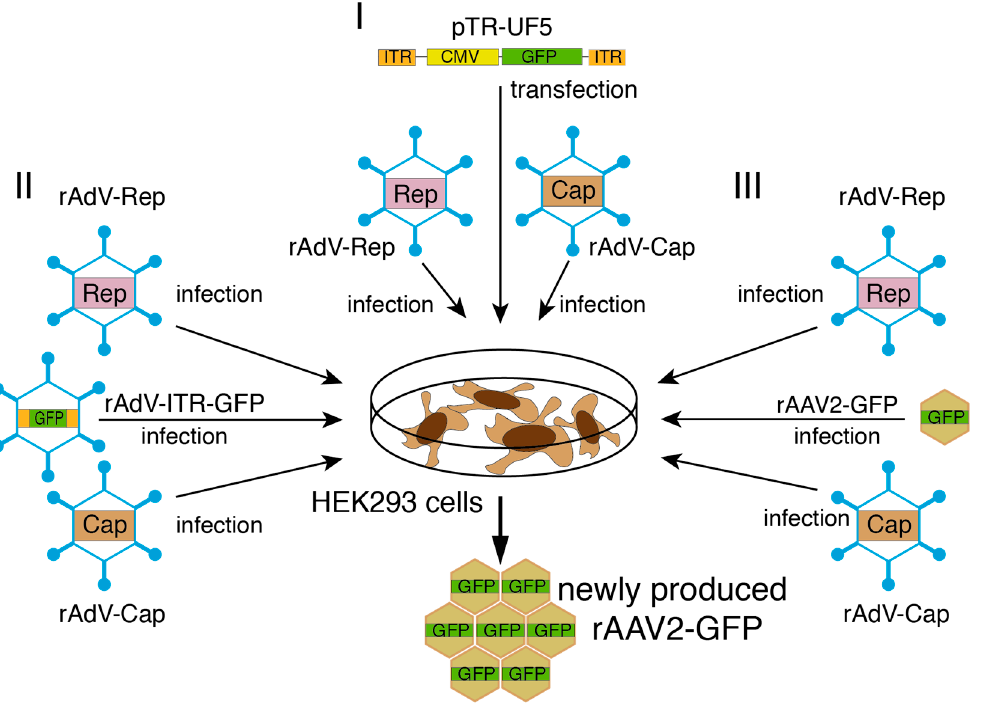
Figure 4. Setups for rAdV-mediated rAAV2-GFP vector packaging. The different experimental approaches for rAdV-mediated packaging of rAAV2-GFP vectors in HEK293 cells are illustrated: ( I ) infection of pTR-UF5 transfected cells with a combination of rAdV-M2-Tet-sRep or rAd-HSV-TK-sRep-Stop531 (generally denoted as rAdV-Rep for simplification) and rAdV-HSV-TK-Cap (denoted as rAdV-Cap ), ( II ) triple rAdV infection with rAdV-Rep, rAdV-Cap and rAdV-ITR-GFP providing the AAV-2 ITR flanked CMV-GFP transgene cassette and ( III ) amplification of low input amounts of rAAV2-GFP by coinfection with rAdV-Rep and